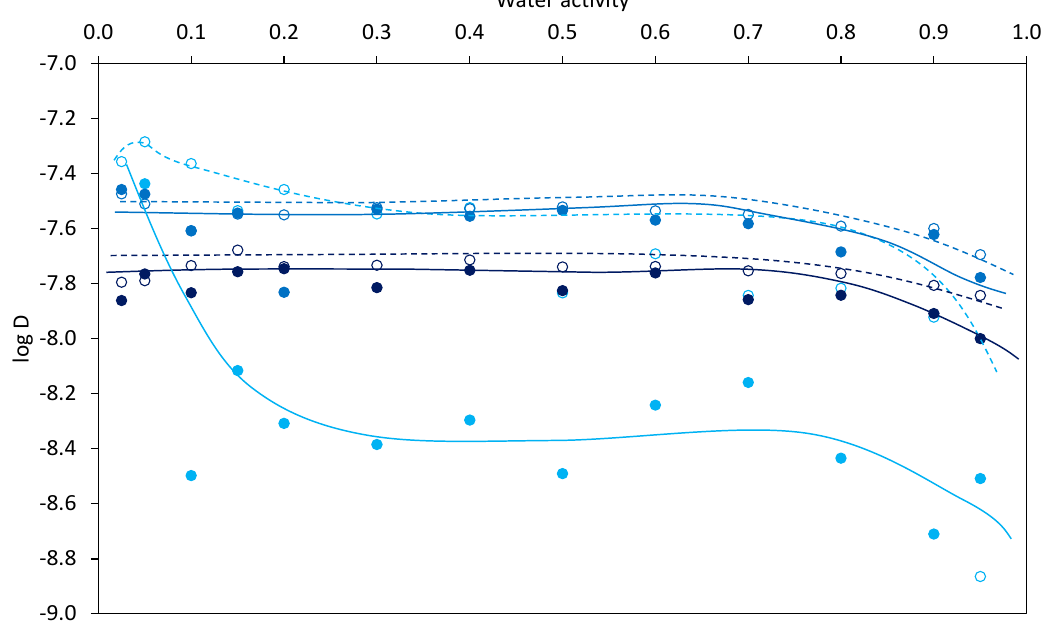
ff usion coe ffi cients D 1 and D 2 for the neat PBSA and the filled PBSA Figure 6. Water vapor diffusion coefficients D 1 and D 2 for the neat PBSA and the filled PBSA films. Figure 6. Water vapor di